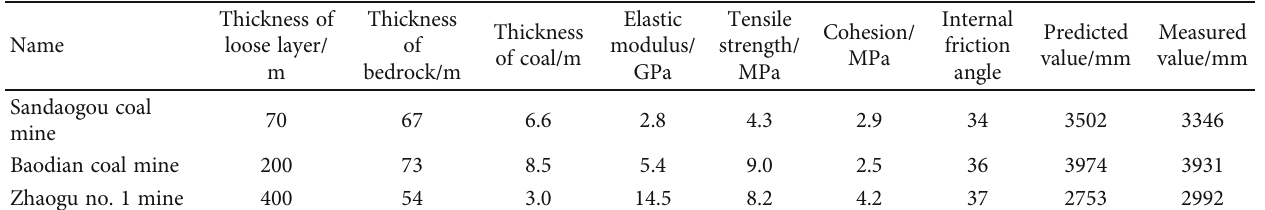
Table 3: Comparison of measured and predicted results of maximum subsidence in some coal mines.